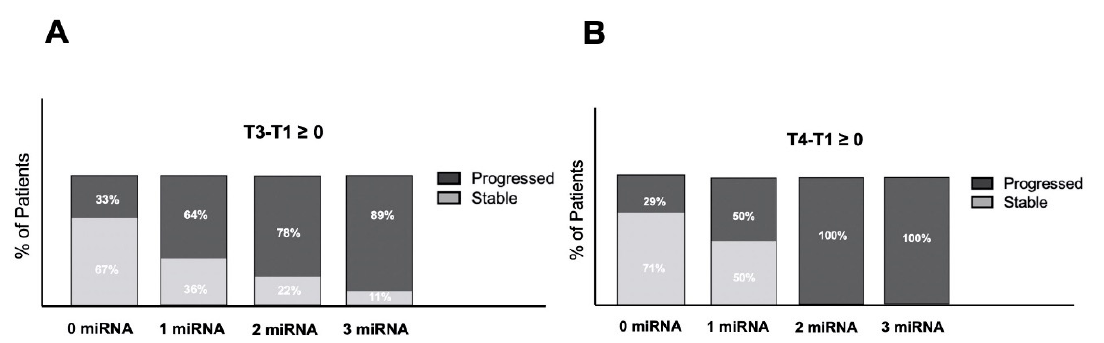
Figure 4. Percentage of patients showing increased expression levels of miRNAs during the follow up. Differences between expression at T3 (17 weeks post-surgery) ( A ) and T4 (25 weeks post-surgery) ( B ) and those at T1 in patients showing Stable or Progressed disease at T5 (33 weeks post-surgery) were calculated, and the percentage of patients with increased levels of none, 1, 2 or 3 miRNAs is reported.